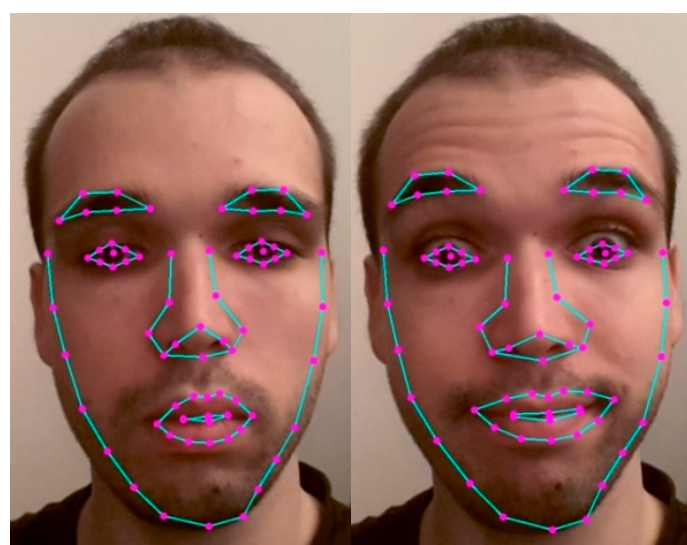
Figure 1. Facial landmarks for AAM algorithm and different facial expressions.